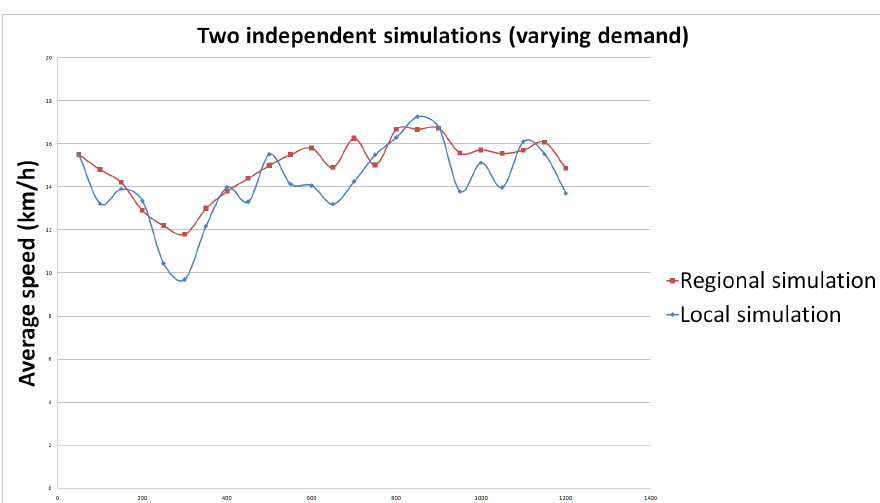
Figure 7. Average speeds for Scenario S1.